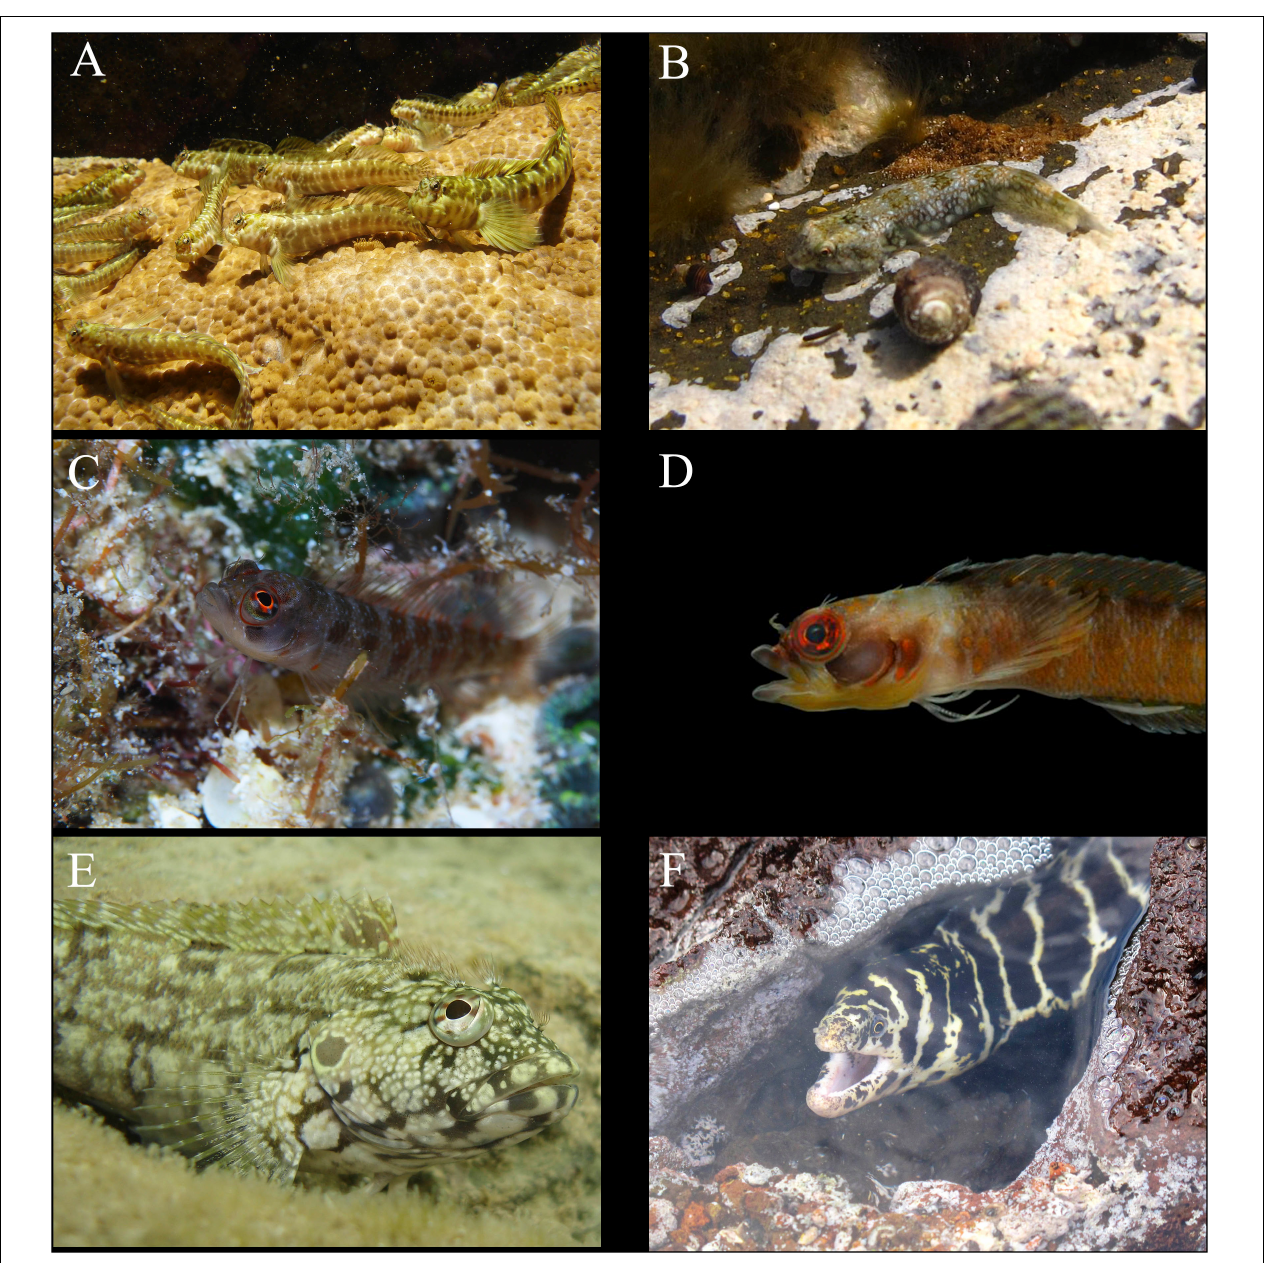
FIGURE 3 | Cryptobenthic intertidal reef fish of the South Atlantic Ocean. A dozen of Entomacrodus vomerinus lumped in a small tidepool (A) . A solitary Tomicodon sp. in a rare moment out of a sea urchin crevice (B) . Starksia multilepis within macroalgal intertices in an intertidal reef (C) and detail of the small mouth of 2 cm sized individual (D) . Juvenile and adult of Labrisomus nuchipinnis (E) often inhabit intertidal reefs, but presented high niche partitioning of habitat and resource uses. The predator Echidna catenata (F) .